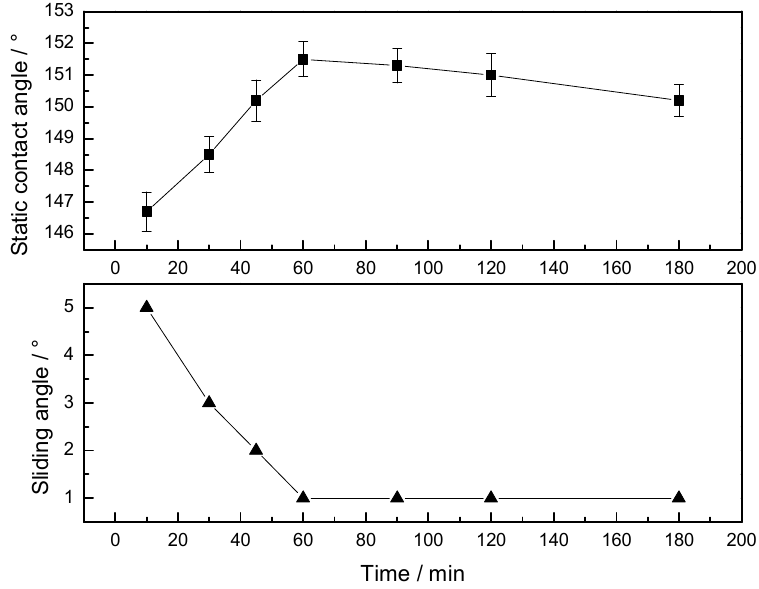
Figure 3. Relationship between SCAs, SAs and immersion time